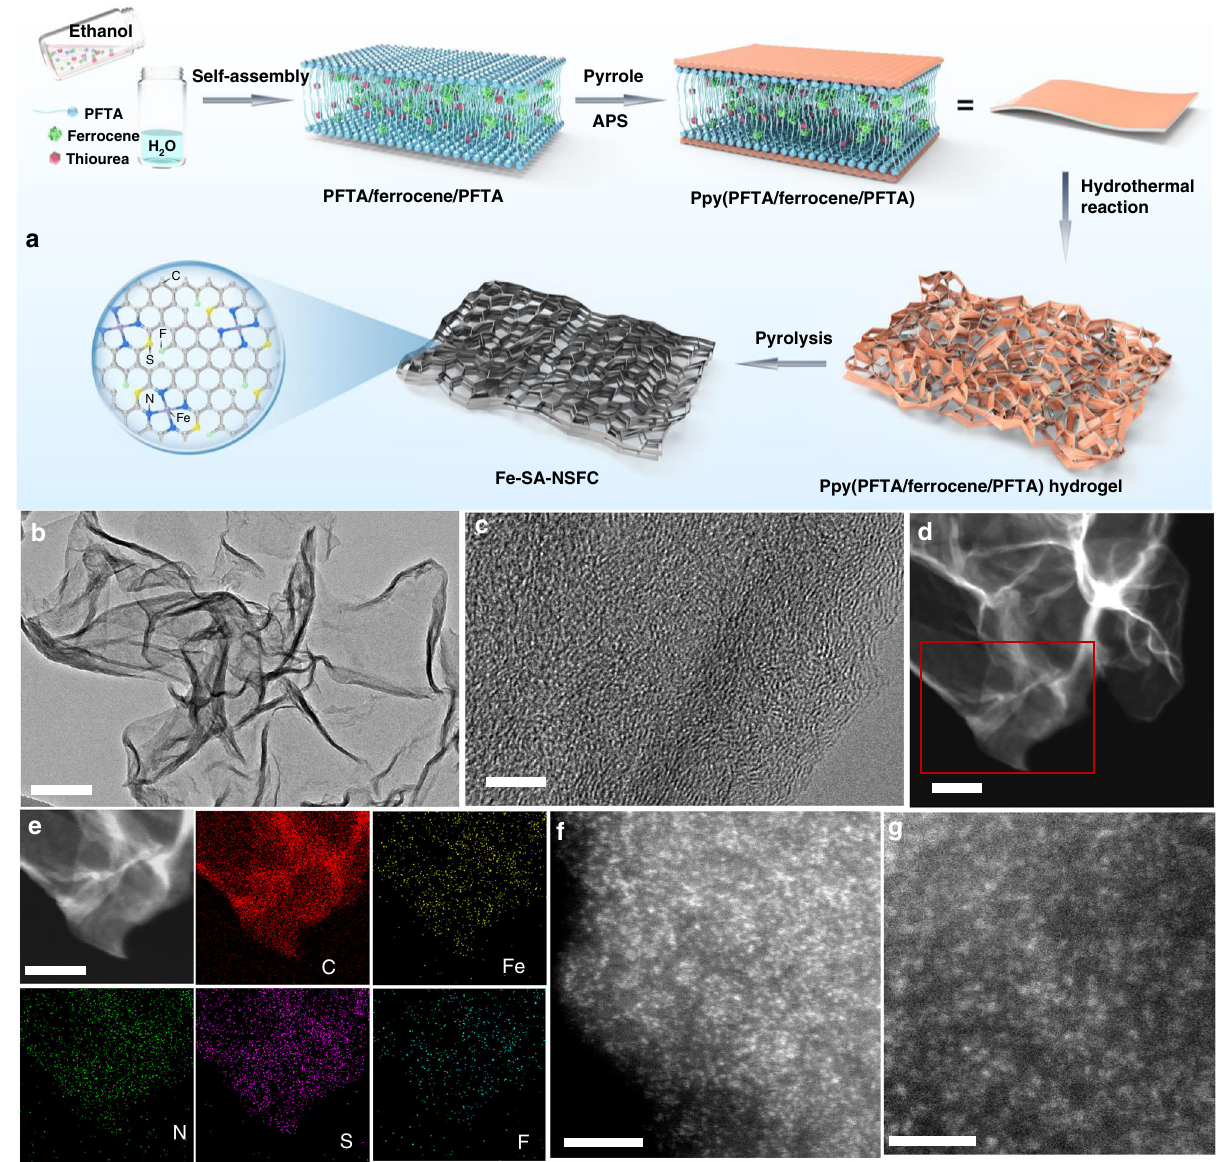
Fig. 1 Synthesis and structural characterization results. a Illustration of the preparation process for the Fe-SA-NSFC and b TEM, c HRTEM, and d HAADF- STEM images of the Fe-SA-NSFC. e Enlarged HAADF-STEM image and corresponding element maps for C, Fe, N, S, and F. f AC-HAADF-STEM image and g high-magni fi cation AC-HAADF-STEM image of the Fe-SA-NSFC. Scale bars: b 200 nm, c 5 nm, d 200 nm, e 100 nm, f 5 nm, and g 2